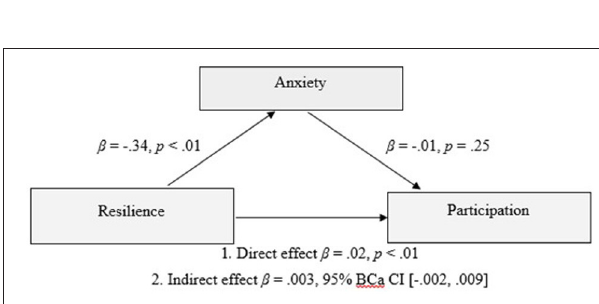
FIGURE 2 | Model of resilience as a predictor of participation outcomes, mediated by anxiety scores of the participant.